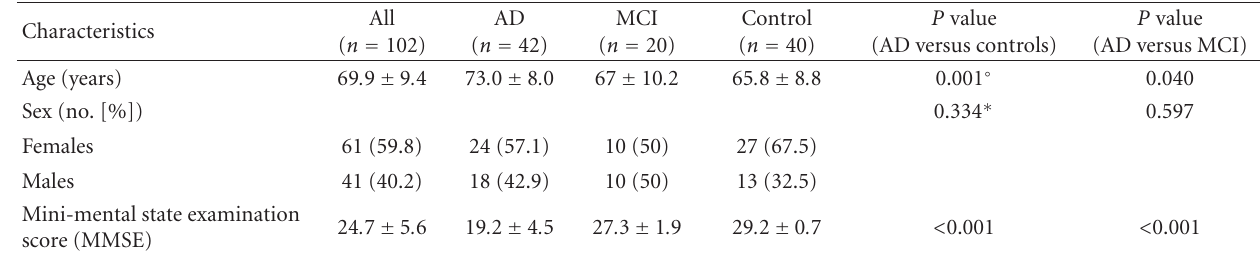
Table 1: Patients’ demographic and clinical details.